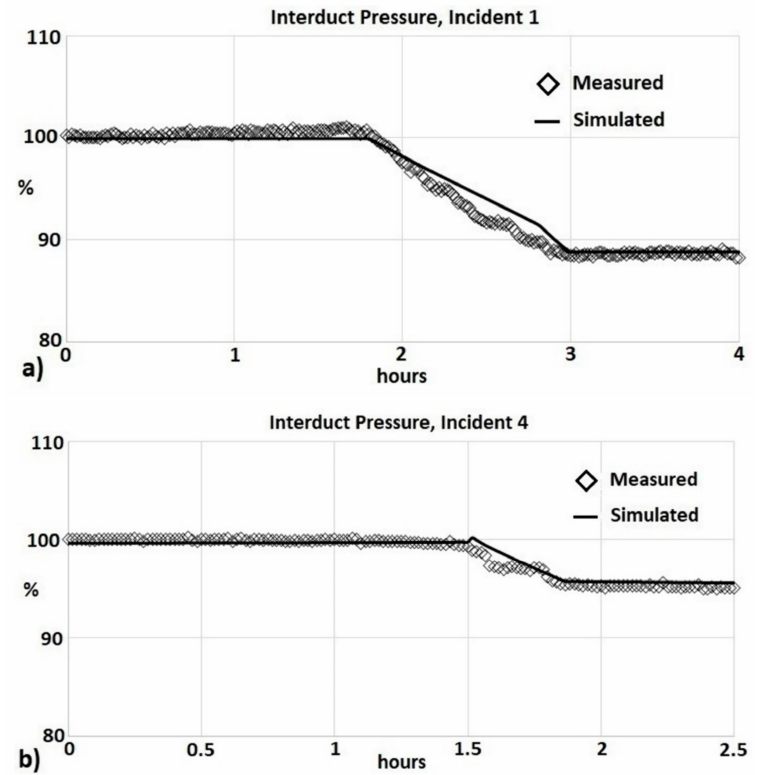
Figure 23. Measured and simulated interduct pressures: ( a ) Incident 1; ( b ) Incident